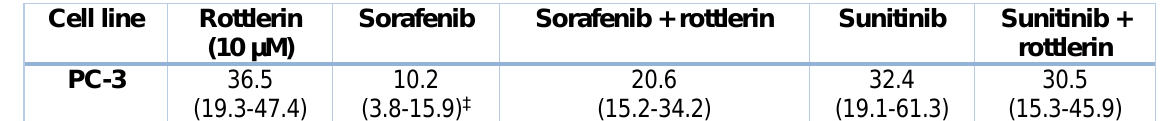
Table 3: Migration of PC-3 prostate cancer cells exposed to sorafenib and sunitinib (5 µM each) with/without rottlerin (10 µM), determined in a Boyden chamber with fibronectin (10 µM) as chemotaxin. The results presented as medians (interquartile ranges) of the activity in the percentage of unexposed control